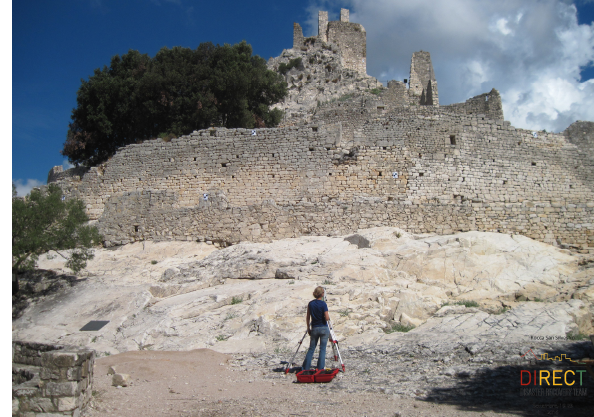
Figure 1. Rocca San Silvestro, south view of the site-starting point of the guided tour.